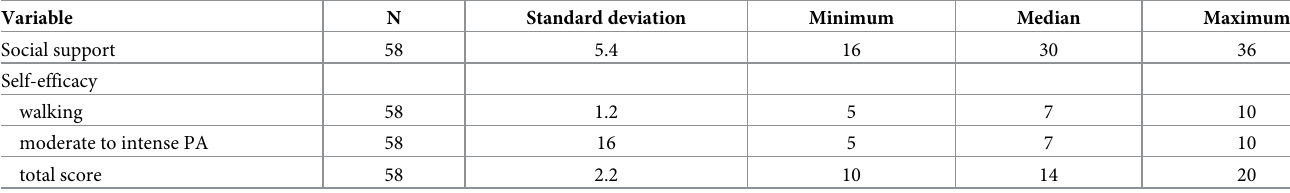
Table 2. Social support and self-efficacy scores for physical activity in the study cohort. Variable N Standard deviation Minimum Median Maximum Social support 58 Self-efficacy walking moderate to intense